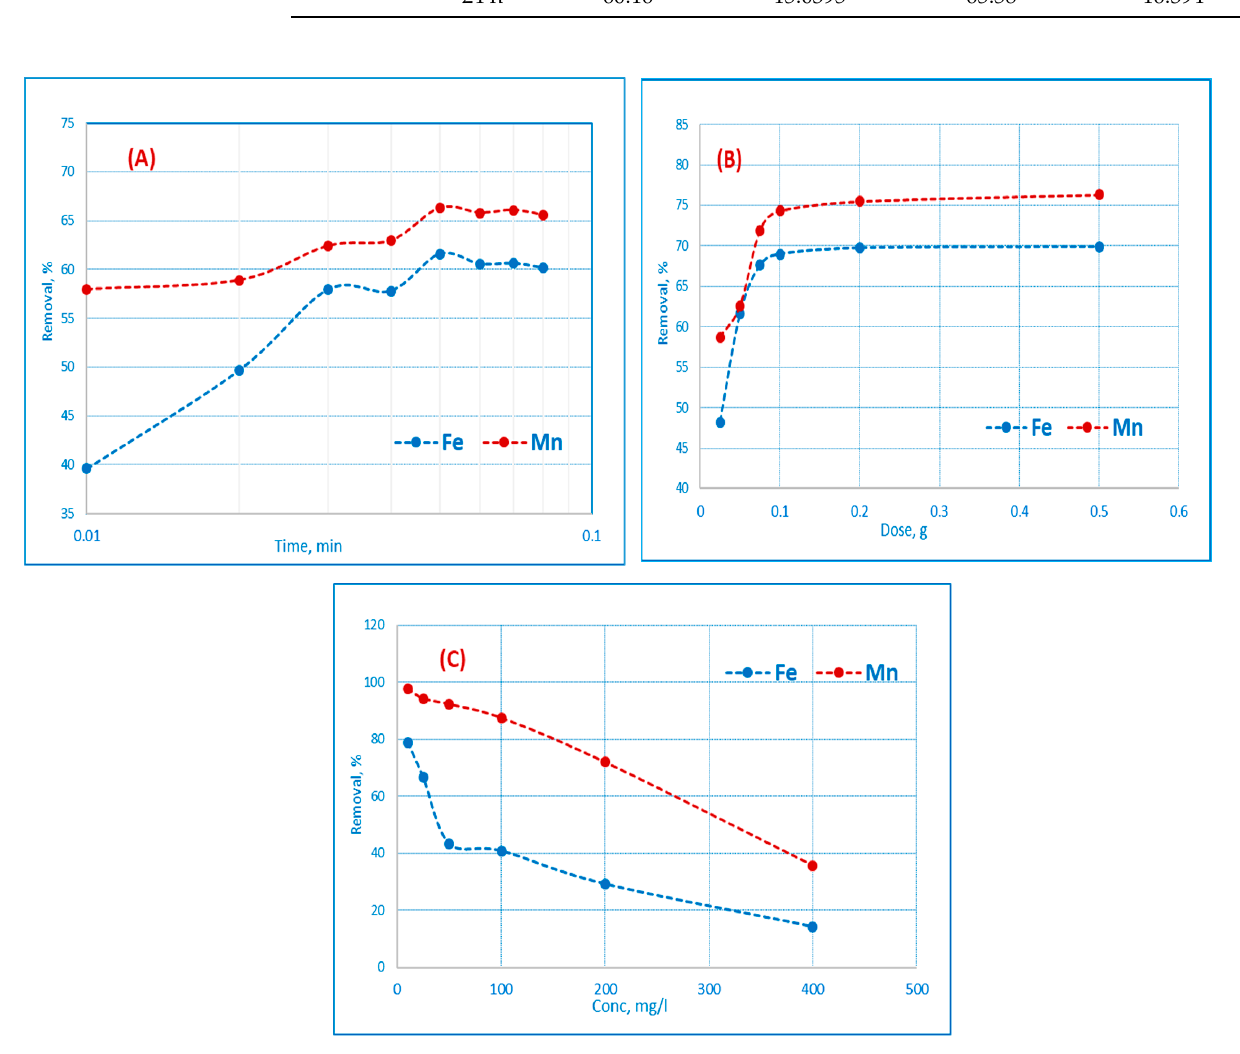
Figure 7. Effect of ( A ) adsorbent dosage, ( B ) concentration, and ( C ) contact time on Fe(III) and Mn(II) percentage removal by AC(C-3) (time = 60 min, pH = 3 and 6 respectively for Fe(III) and Mn(II), agitation velocity = 100 rpm and temp = 25 °C). Table 8. The influence of initial concentration of metal ions on the absorption and removal by AC (C- 3) of Fe(III) and Mn(II) from aqueous solutions (conc. = 50 mg/L, time = 1 h, wt. = 0.05 gm, agita- tion velocity = 100 rpm and temp. 25 °C) by percentage.